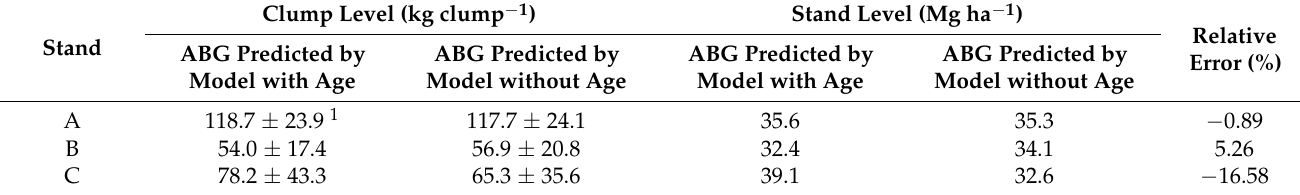
Table 4. The prediction of aboveground biomass (AGB) at the clump and stand levels based on the allometric functions with and without an age factor for Ma bamboo, where the relative error (%) was calculated as [(ABG predicted by model without age − ABG predicted by model with age)/ABG predicted by model with age] ×